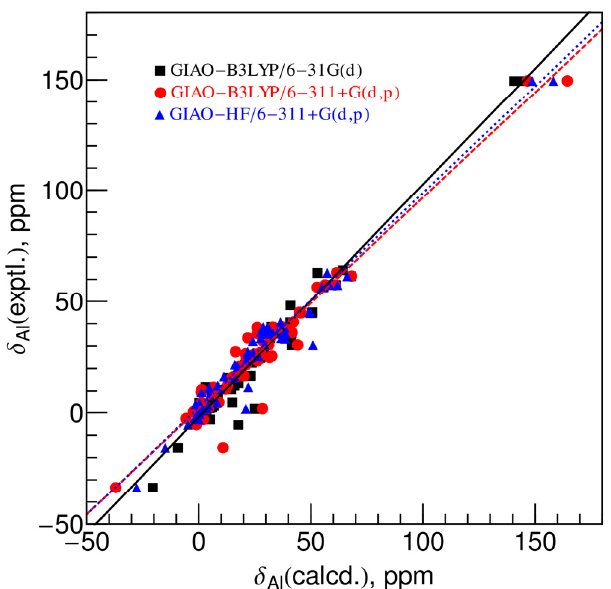
Figure 3. Correlation between the experimental 27 Al chemical shifts versus the calculated values using the X-ray crystallographic geometries at the GIAO-B3LYP/6-31G(d) (black squares), the B3LYP/6-311+G(d,p) (red circles) and the HF/6-311+G(d,p) (blue triangles) levels. The black solid line, the red dashed line and the dotted blue lines are the best-fit linear regression of the three data sets, respectively, and the best-fit equations are given in Equations